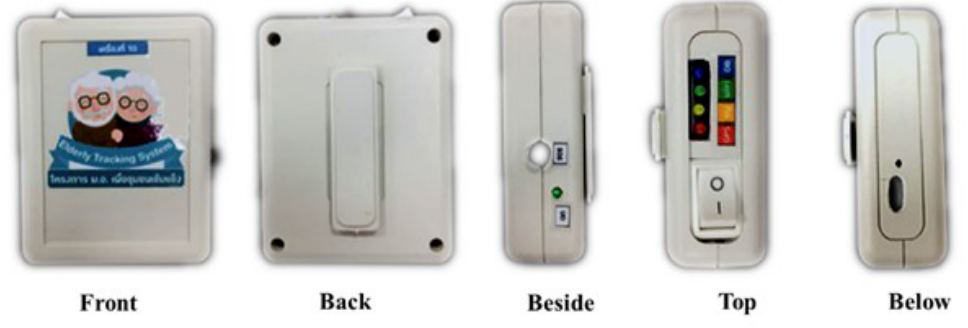
Figure 4. The external appearance of the tracking